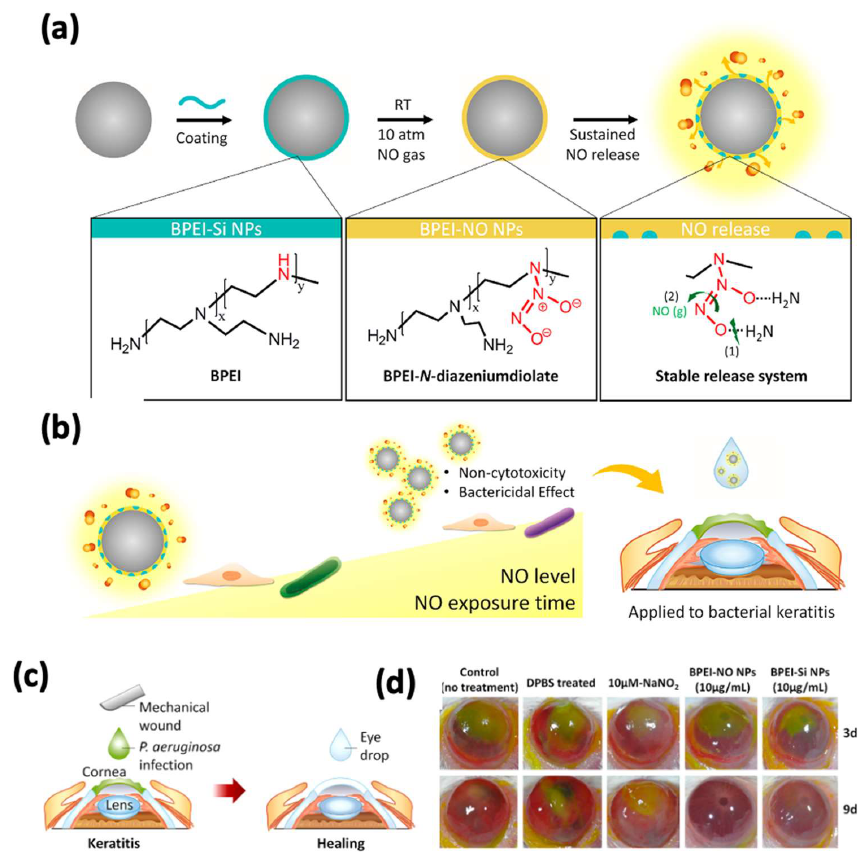
Figure 4. Antibacterial contact lenses with NO* generation. ( a ) Schematic illustration of functionalized CLs. ( b ) Illustration of the effects of CLs on cells and bacteria depending on the concentration and exposure time of NO*. ( c ) Schematic illustration of wound healing experiment. ( d ) Images of mouse corneas treated with CLs. Reproduced with permission of reference [68].